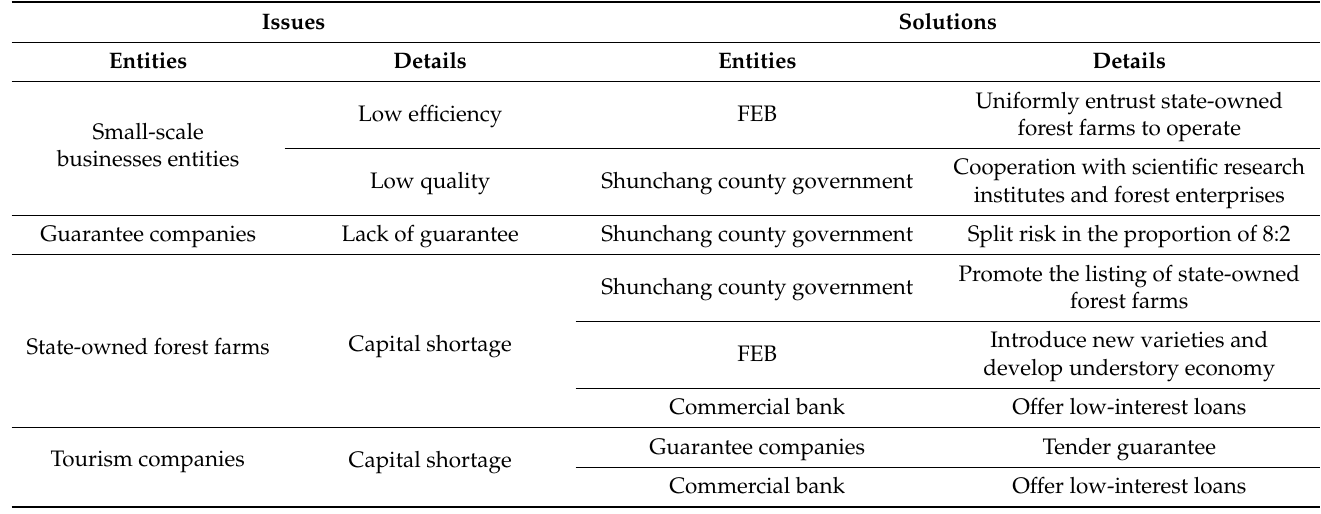
Table 3. Issues encountered in the dissidence stage and solutions of typical